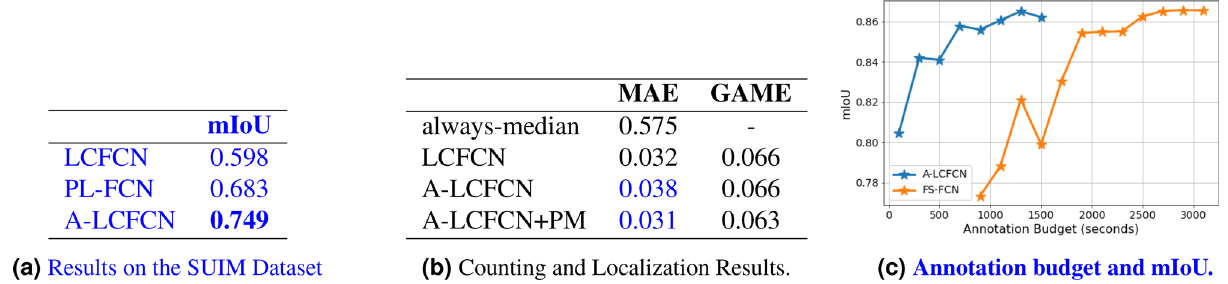
Figure 5. Additional results on ( a ) the SUIM Dataset, ( b ) counting and localization, ( c ) Annotation